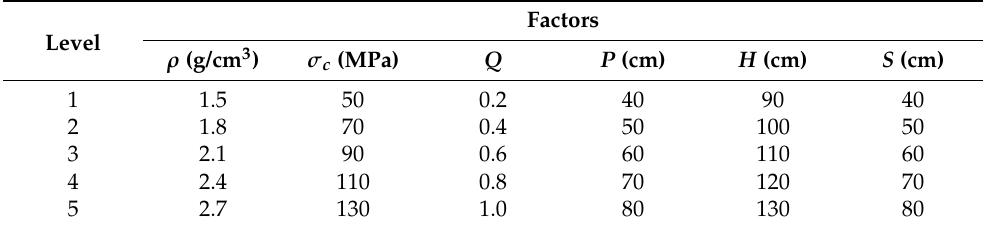
Table 7. The influencing factors and level of the cataclastic structure rock mass.